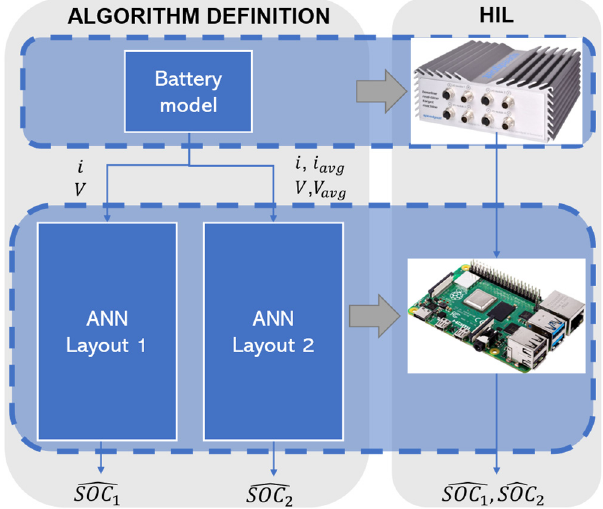
Figure 1. Flowchart of the proposed approach for the estimation of the SOC. Eventually, the SOC estimation algorithm design and testing procedures are described in a dedicated subsection that illustrates the two considered ANN layouts. Moreover, the training algorithm and datasets are also discussed in this